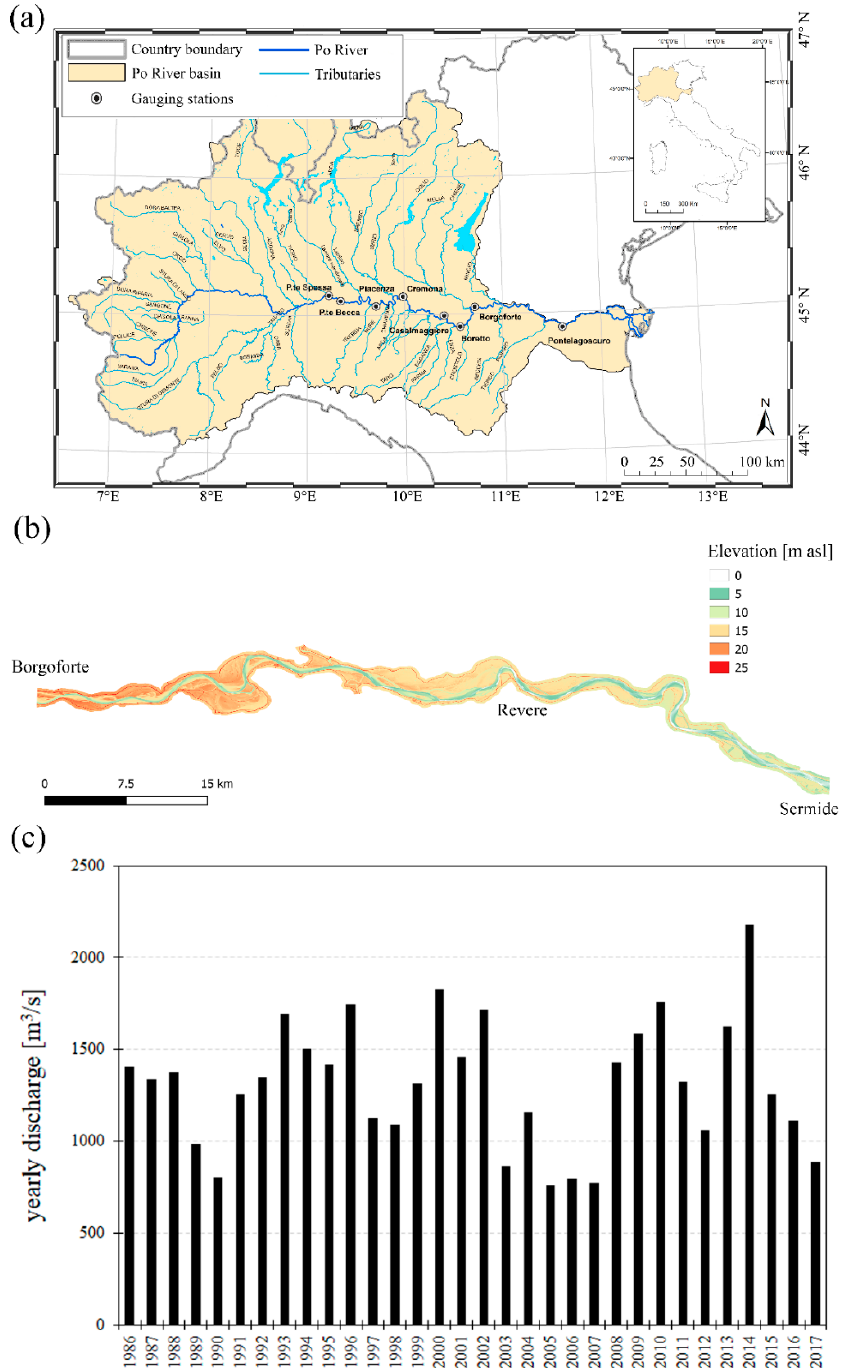
Figure 1. ( a ) Po River basin; ( b ) DEM of the studied area, from the upstream end of Borgoforte to the downstream end of Sermide; ( c ) yearly time series of flow discharge measured between 1986 and 2017 at the gauging station of Borgoforte (Mn).